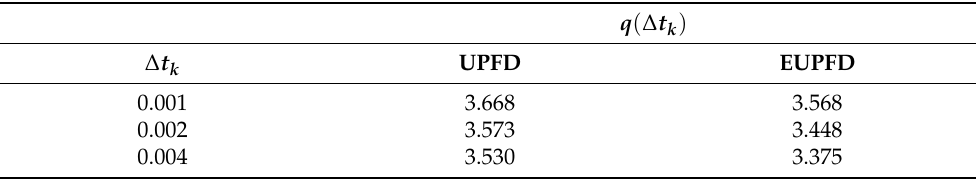
Table 1. Convergence rates for the linear ADR equation by the UPFD and EUPFD with respect to ∆ t and a fixed ∆ x = 0.025.